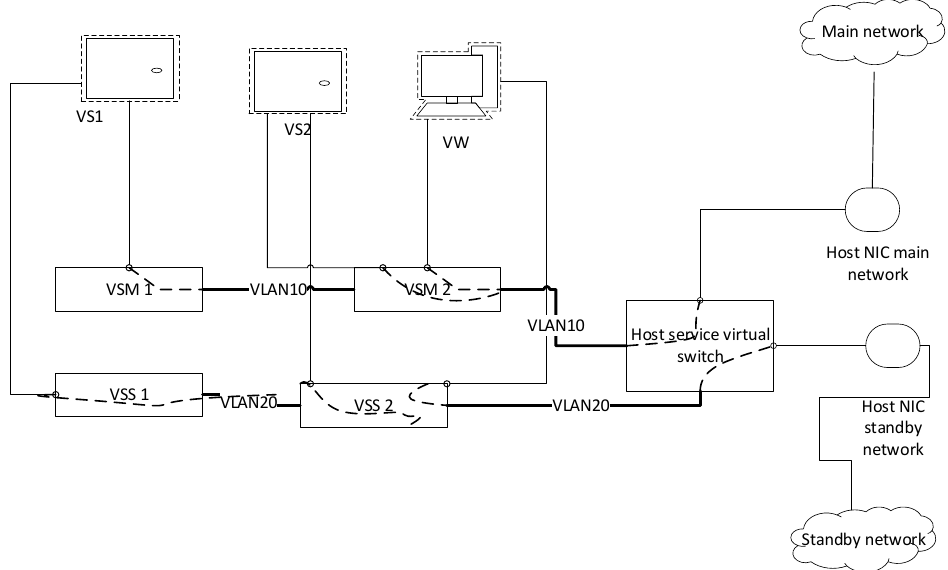
Figure 7. A fragment of the digital twin network topology.